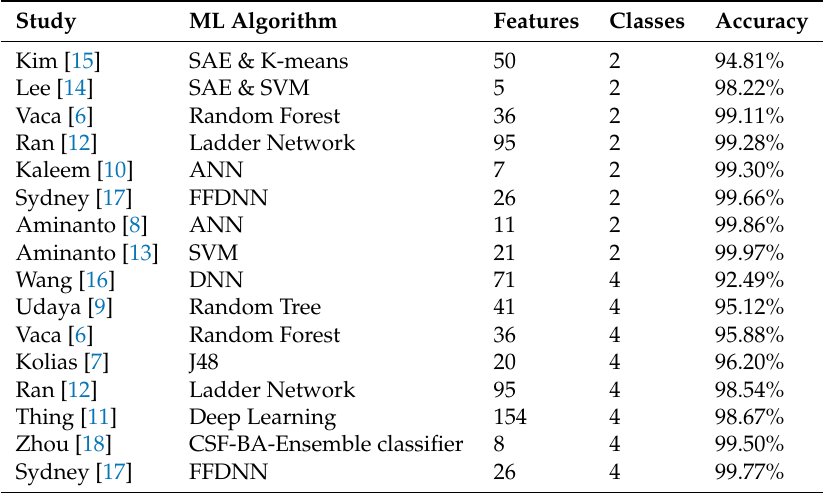
Table 1. Summary of the related works for Wi-Fi NIDS using an AWID